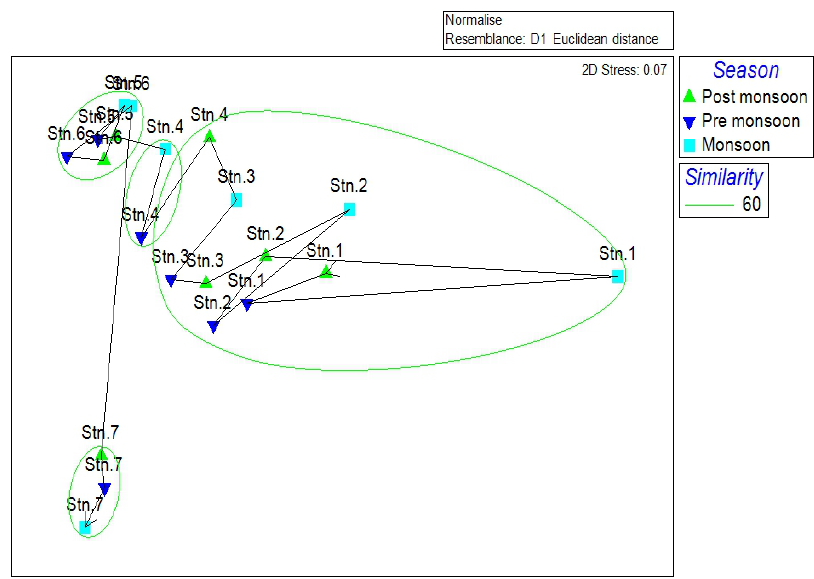
Fig. 3: MDS plot illustrates seasonal percentage similarity of sampling stations based on Euclidean cluster plot